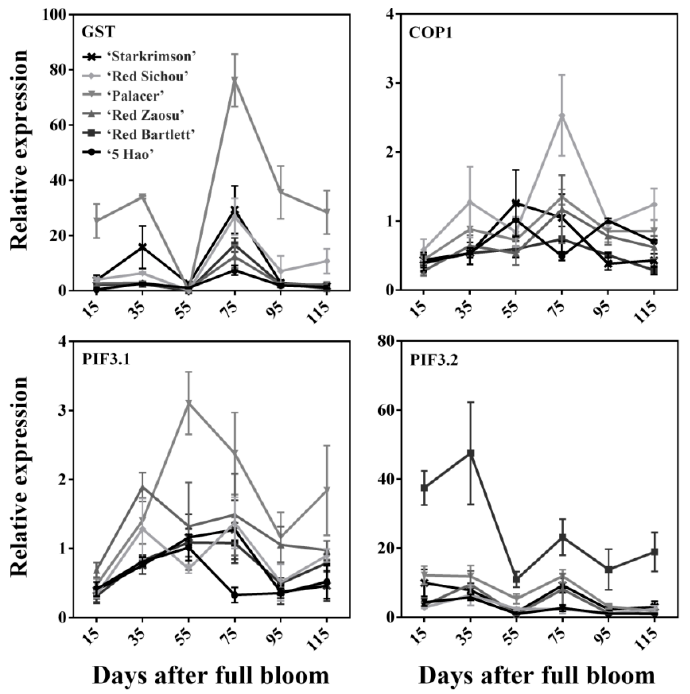
Figure 4. Relative expression levels of the anthocyanin biosynthesis-related transporter and light-responsive genes of six red pear cultivars at different stages of fruit development.